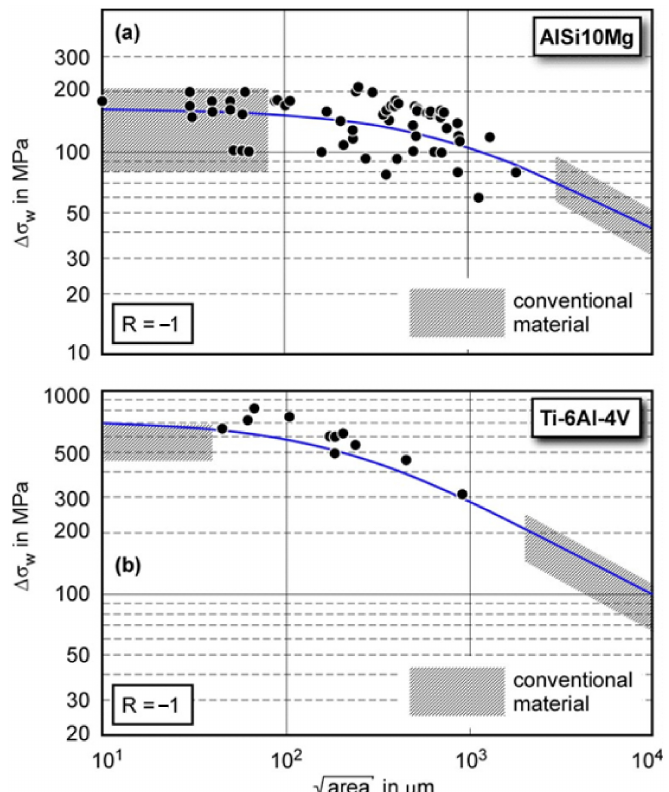
Figure 8. KT diagrams based on literature data for ( a ) L-PBF AlSi10Mg and ( b ) L-PBF Ti-6Al-4V [37]. The term ∆ σ w designates the endurance limit ∆ σ e at R = − 1. The blue solid curves have been obtained by the El Haddad approach (Equation